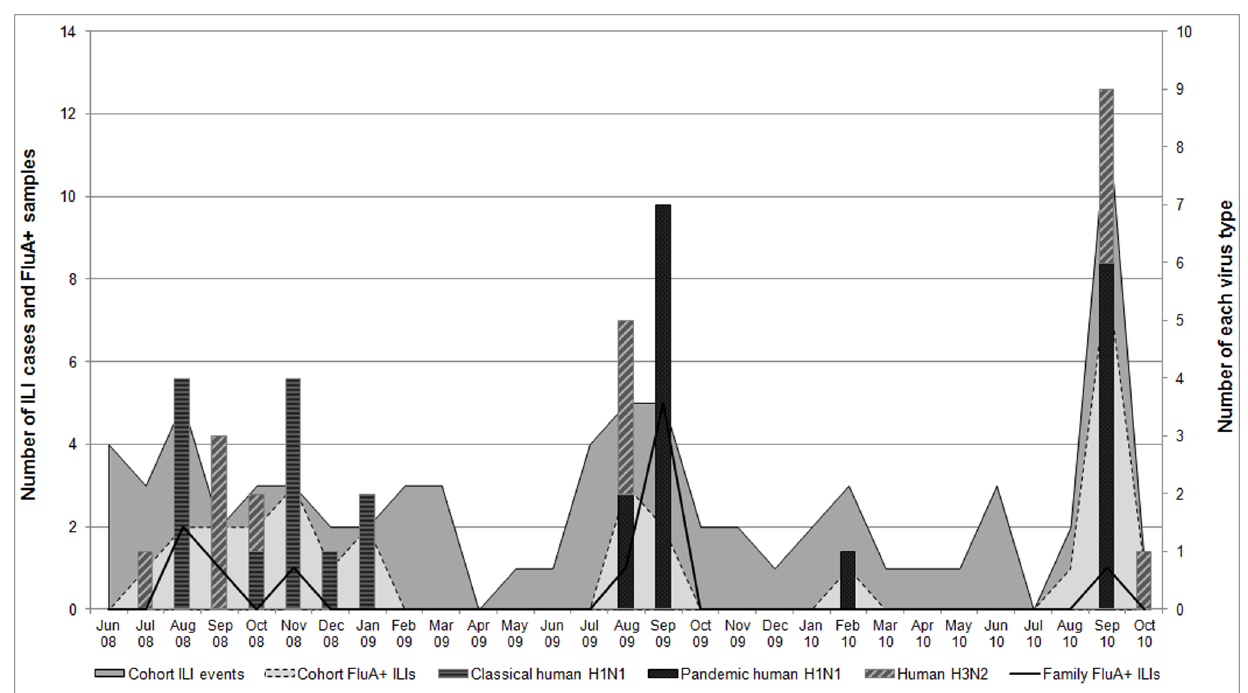
Figure 1. Reported influenza-like illnesses with real-time RT-PCR results of respiratory swabs collected from study cohort members and their family contacts at time of illness; June 2008–November 2010; Kamphaeng Phet, Thailand.